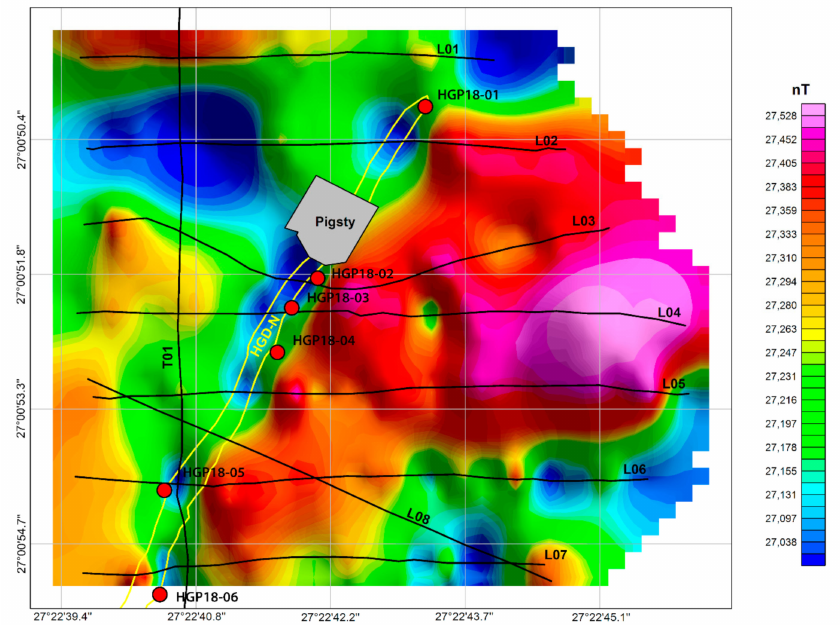
Figure 6. Contour map of the total magnetic field intensity recorded across the northern outcrop of the Holfontein Granophyre Dike (HGD-N). Data collection lines are indicated in black. Geological samples are indicated with red